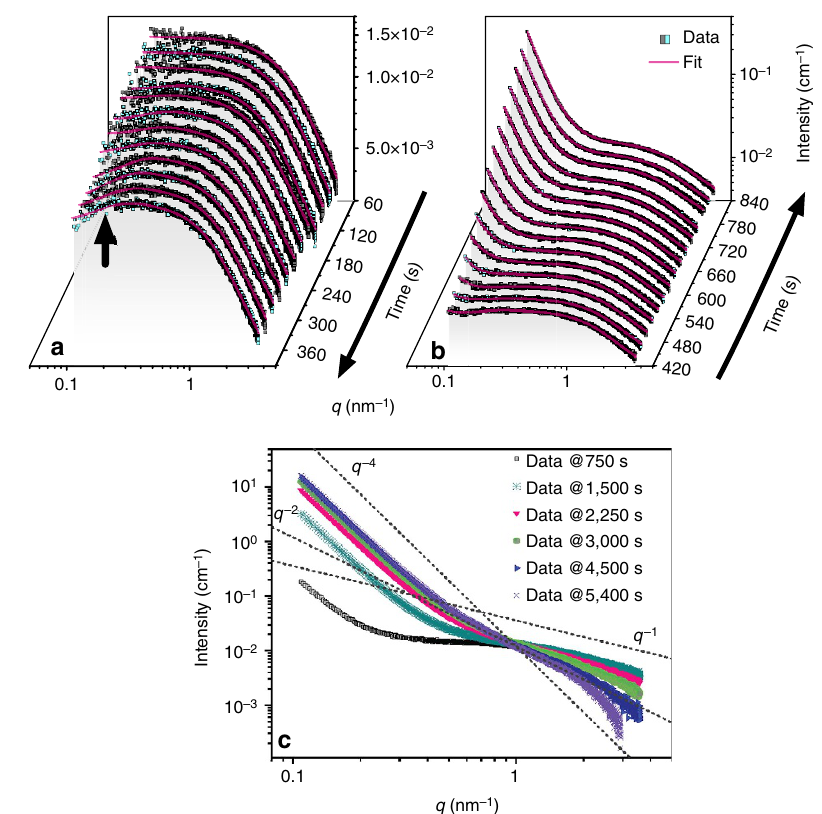
Figure 2 | SAXS patterns in stages I–III. ( a ) The first 390s (stages I and II, excluding a frame at 30s). The arrow points to the part of the curve affected by the structure factor; ( b ) Stage III as represented by the SAXS patterns between 420 and 840s (solid lines represent best fits as described in the main text; please note that the directions of the time-axes in a and b are different); ( c ) progressive change in the intensities in the SAXS patterns between 750 and 5,400s indicating the transitions from stages I–IV, and showing the I ( q ) dependencies and the change in scattering exponents (dashed